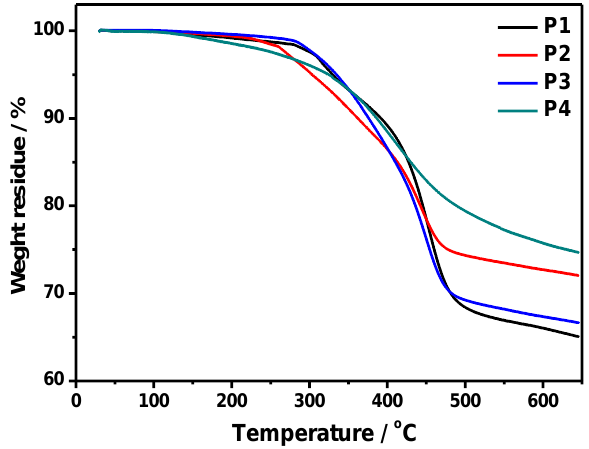
Figure 2. TGA curves of the polymers (P1, P2, P3 and P4).